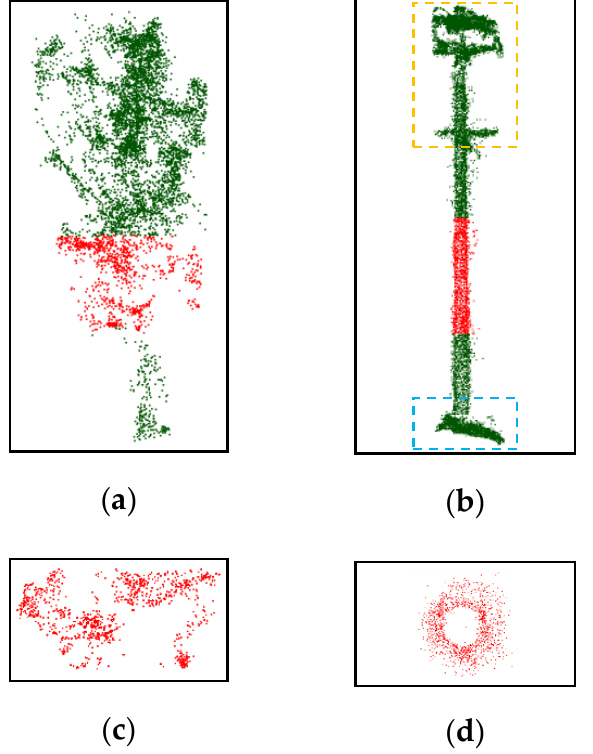
Figure 5. The location of the backbone area and its projection: ( a ) main view of vegetation; ( b ) main view of line pole; ( c ) top view of vegetation; ( d ) top view of line pole. In Figure 6a, the black dots are the horizontal projection points of the backbone of a specific candidate telegraph pole, the blue dashed box indicates the maximum and minimum values of the point cloud data on the x and y axes, and the red dashed box is the actual circumscribed rectangle of the point cloud data. A significant error will occur while calculating the side length by determining the four corners of the circumscribed rectangle of the horizontal projection of the backbone if the corners of the point cloud data are determined according to their maximum and minimum values in the x and y- axis directions. Therefore, the coordinate system rotation method is employed to extract the corner coordinates of the point cloud data, and the side lengths of the circumscribed rectangle are then calculated as follows. Since the rectangle is a centrally symmetrical figure, the red dotted rectangle with the smallest area can be found within 90 ◦ of its coordinate origin, which is the actual circumscribed rectangle of the point cloud data, as shown in Formula (1), where ( x 0 , y 0 ) and ( x , y ) are the coordinates before and after the rotation and α is the angle of counterclockwise rotation. The four green points in Figure 6b are the corner points of the circumscribed rectangle of the black point cloud. By calculating the distance between adjacent corner points, the maximum distance is taken as the length of the circumscribed rectangle. If this length is less than the threshold, the cluster is judged as a pole point, and its center point coordinates are